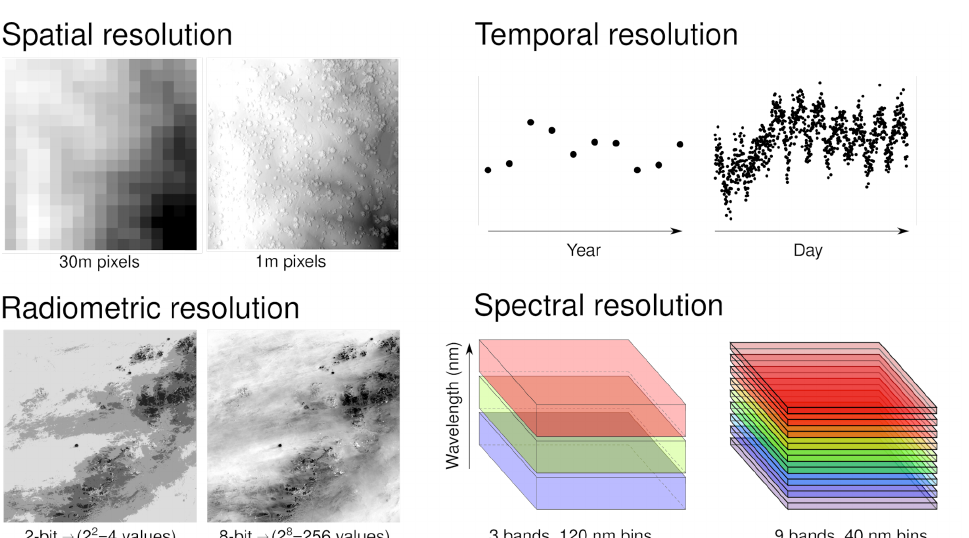
Figure 1: Different kinds of resolution, with examples of lower and higher resolution data. Spatial resolution relates to pixel size, temporal resolution to observation frequency, radiometric resolu- tion to the number of unique values, and spectral resolution to binwidth in the electromagnetic spectrum.